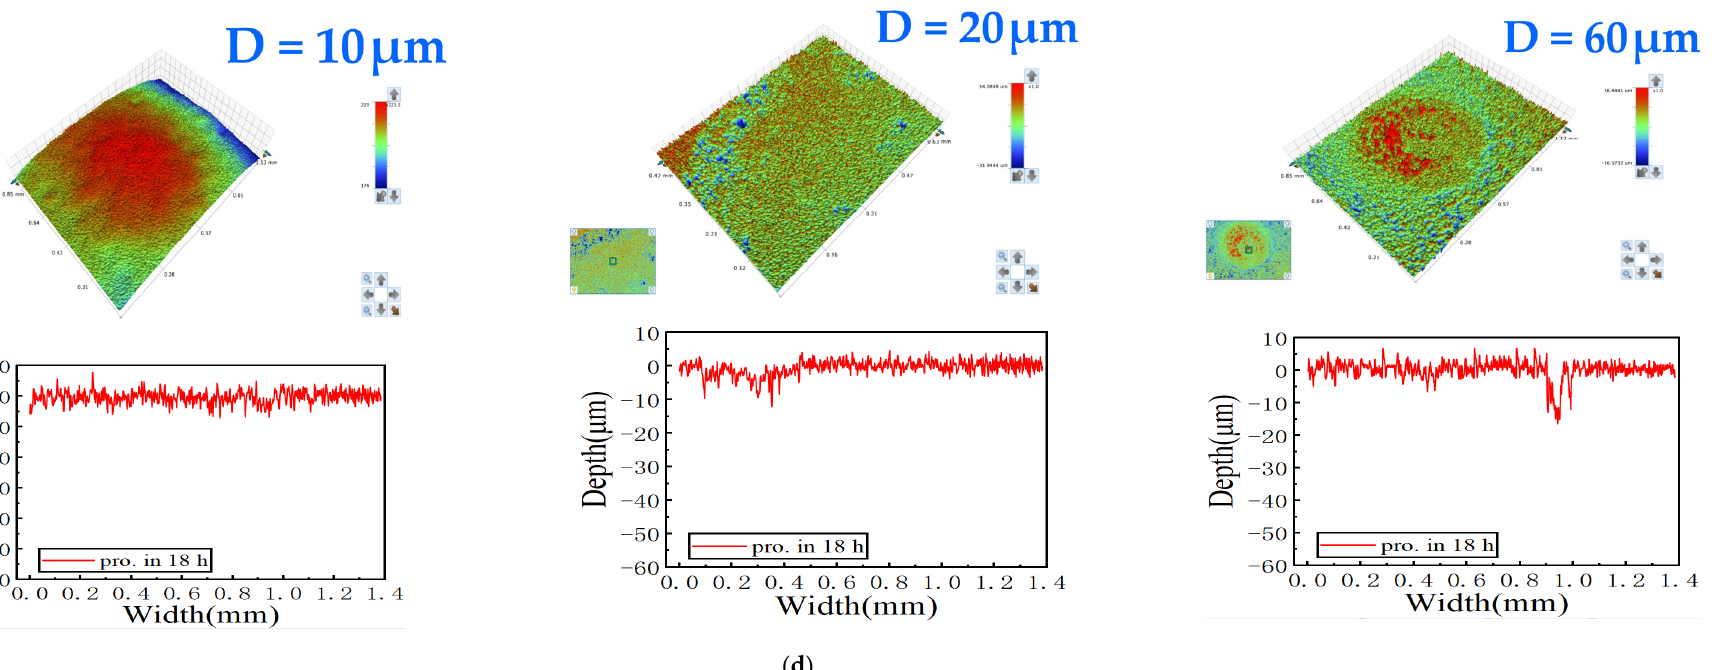
Figure 10. Two-dimensional/three-dimensional morphology of wear scar morphologies on balls after various process times and at different displacement amplitudes. ( a ) Untreated; ( b ) pro. in 6 h; ( c ) pro. in 12 h; ( d ) pro. in 18 h.